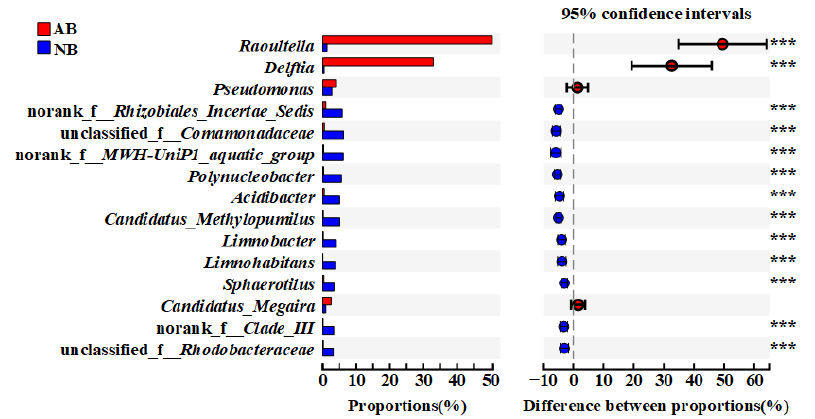
Figure 3. Differences in the top 15 genera in Proteobacteria among B. calyciflorus -associated bacterial and bacterioplankton communities. The analysis was based on the Student’s t -test. *** p ≤ 0.001.